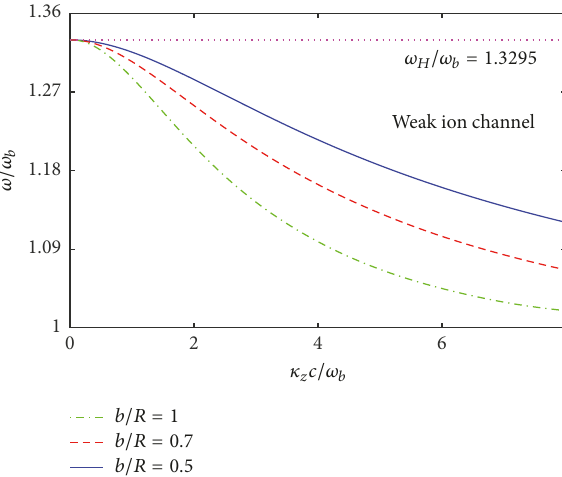
Figure 8: The effect of the ratio 𝑏/𝑅 on the dispersion curves of the SC 01 modes for weak ion channel with 𝜔 𝛽 = 0.8761 . The inner radius of the annular beam is taken as 0.25 R . 𝑏/𝑅 = 1 represents the waveguide completely filled with the annular beam.